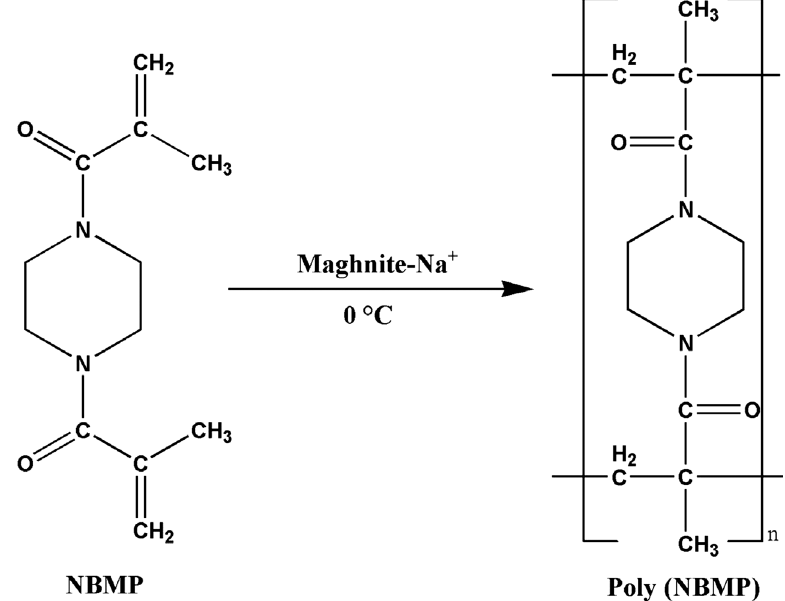
Figure 2: Representative scheme for the polymerization of NBMP catalyzed by maghnite-Na +